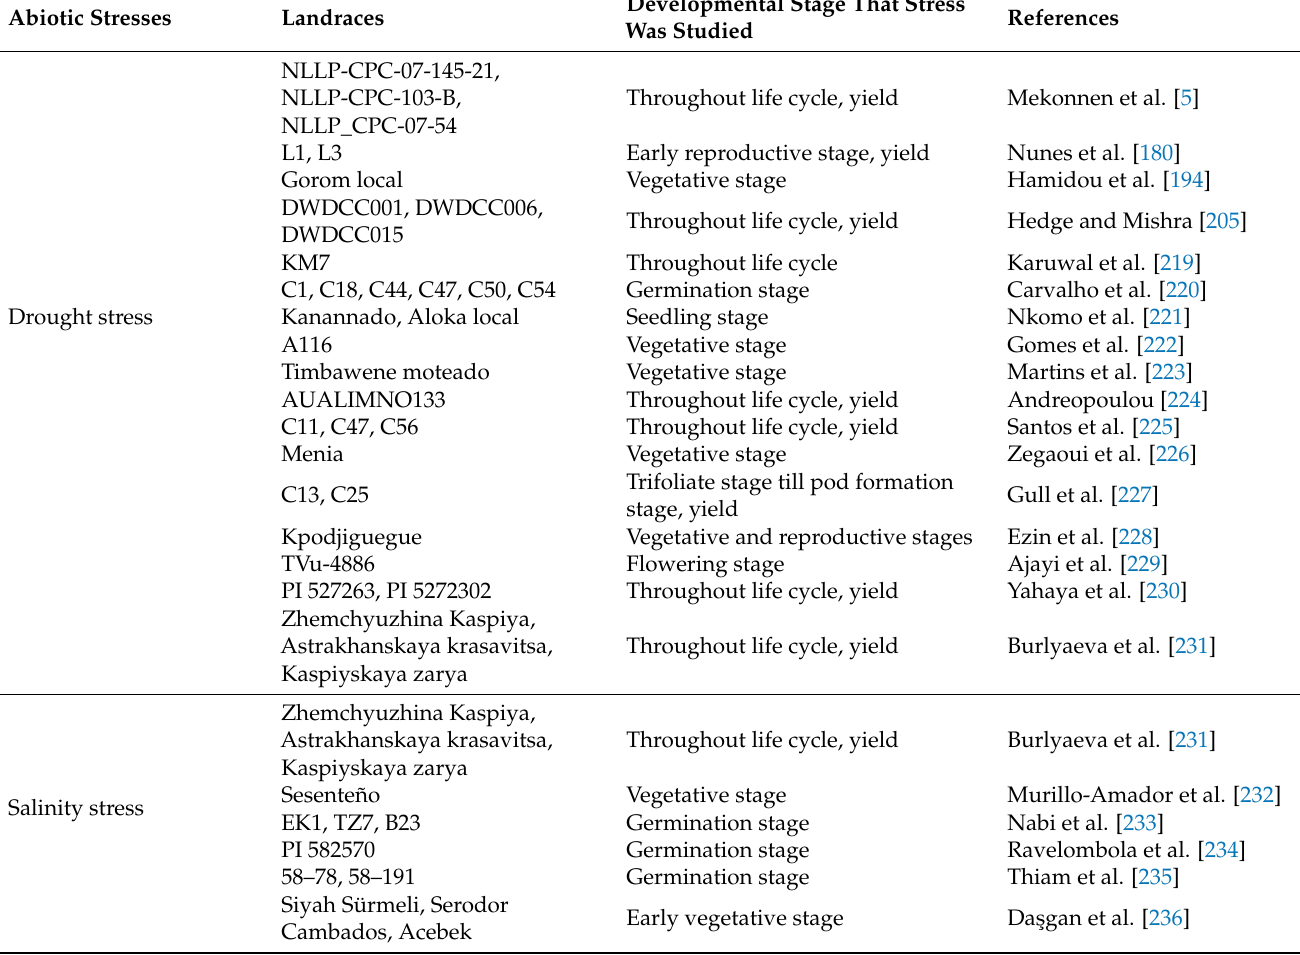
Table 4. Cowpea landraces with potential to tolerate drought and salinity